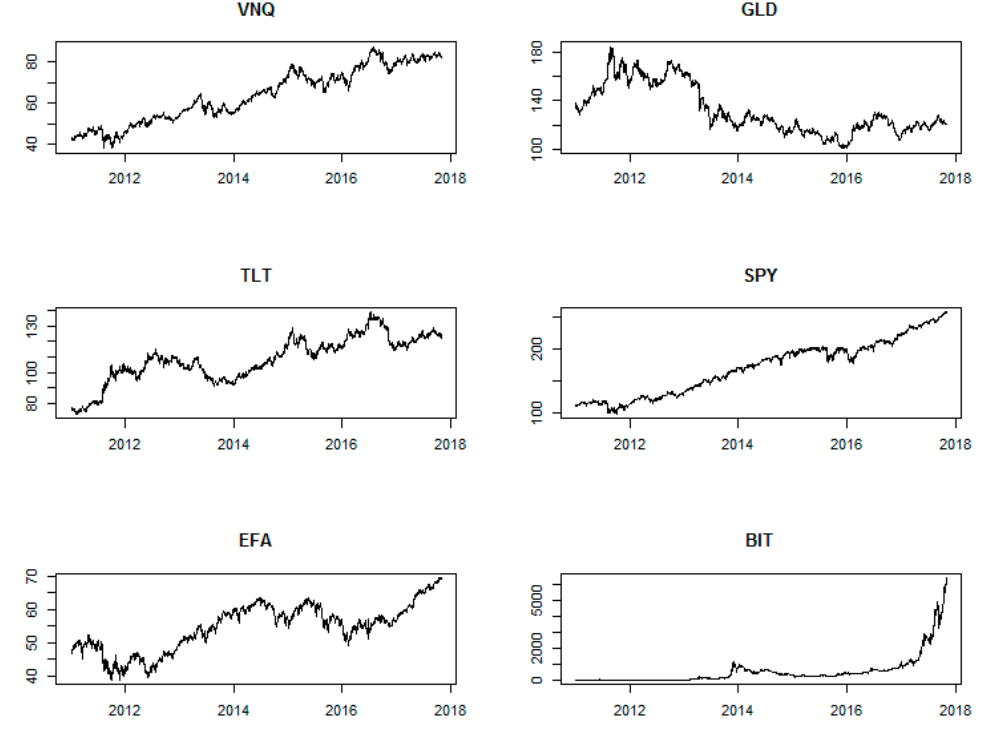
Figure 1. Time series plots of assets. Table 1. Summary statistics for daily percent returns.